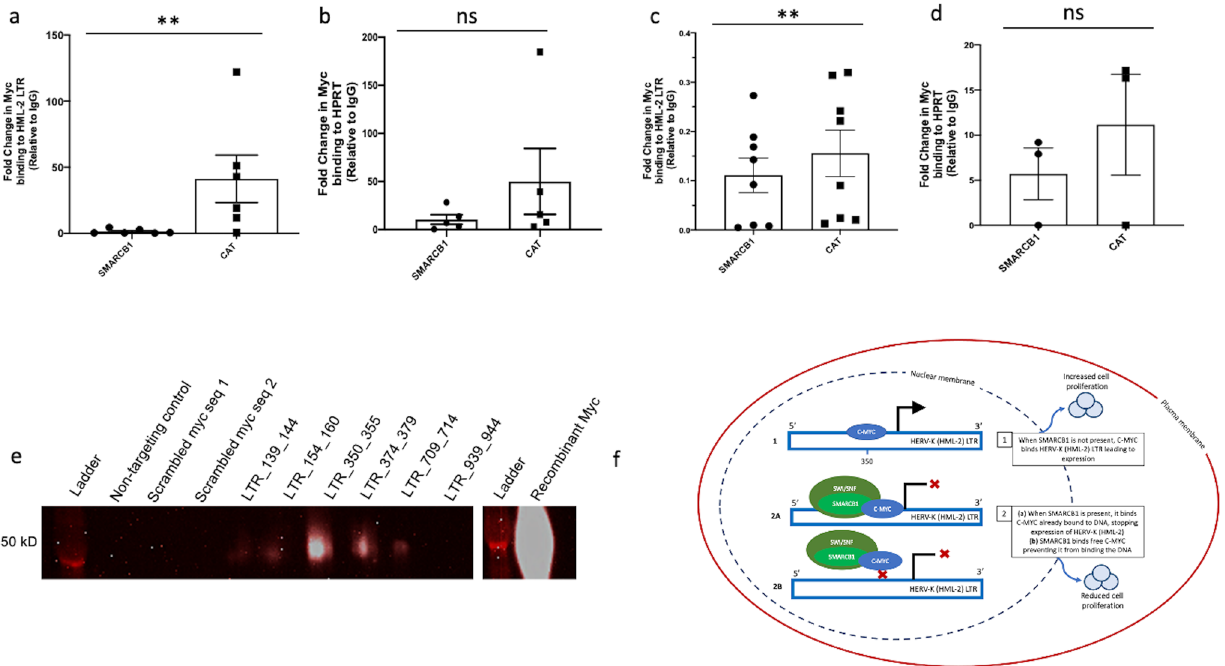
Figure 7. C-MYC binding to the HERV-K (HML-2) LTR. ( a – d ) C-MYC binds HML-2 LTR significantly less when SMARCB1 is expressed. Panel a: Relative quantification of HML-2 LTR bound to C-MYC transcription factor binding protein immunoprecipitated from either 293 T cells transfected with a SMARCB1 plasmid or a control ( CAT ) plasmid. ( b ) Relative quantification of housekeeping gene HPRT bound to C-MYC post- immunoprecipitation from 293 T cells transfected with either SMARCB1 or a control ( CAT ) plasmid. ( c ) Relative quantification of C-MYC bound to the HML-2 LTR post immunoprecipitation in CHLA 02 cells transfected with either SMARCB1 or with CAT plasmid. ( d ) Relative quantification of CMYC bound to housekeeping gene HPRT post immunoprecipitation in CHLA 02 cells transfected with either SMARCB1 or with CAT plasmid. Percent input is a normalized value with input set to 100% (e.g. % input = 100*2^(input Ct − immunoprecipitated chromatin Ct). Ct is cycle threshold. ( e ) C-MYC binds the HML-2 LTR in vitro. Biotinylated nucleotides with a non-targeting sequence, a scrambled canonical C-MYC binding sequence, or varying sequences from the Chr7p22.1a or Chr7p22.1b HML-2 LTR were incubated with recombinant C-MYC protein, washed, and run on an immunoblot to detect specific binding between C-MYC and different sequences. There is a white line between the the final LTR_939_944 and another ladder depicting that a portion of the gel was deleted to simplify the figure. The full gel image can be found in the supplemental information. ( f ) Contains a diagram of the mechanism by which HML-2 expression is regulated in the absence or presence of SMARCB1 protein. ( f1 ) shows how HML-2 is actively expressed when C-MYC is bound to the LTR (promoter) when SMARCB1 protein is not expressed, while ( f2 a,b) depict the SMARCB1 mediated inhibition of C-MYC activation of HML-2 transcription. Graphs generated with Prism v9. ( f ) Generated in Microsoft PowerPoint. [Error bars represent SEM. Statistics in Supplemental Table